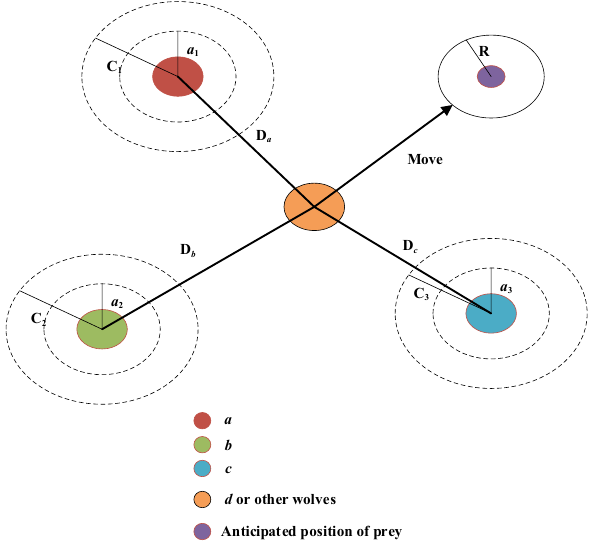
Figure 6. Position updating of